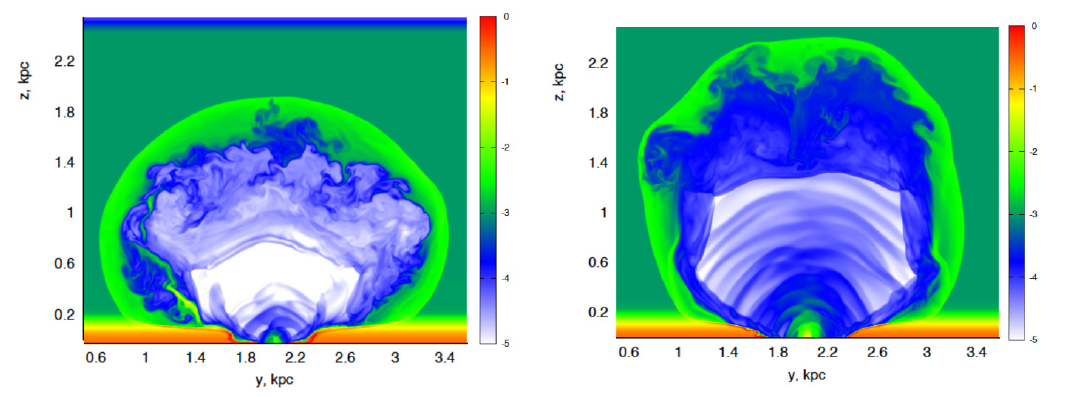
Figure 4. Density maps for superbubbles formed by a central stellar cluster with SNe rates 10 − 4 yr − 1 at t = 4 Myr ( left ), and 10 − 3 yr − 1 at t = 2 Myr ( right ). Clearly seen is a very low density— n < 3 × 10 − 4 cm − 3 inside the bubble, and even an order of magnitude lower n < 3 × 10 − 5 cm − 3 in the domain close to the cluster. From